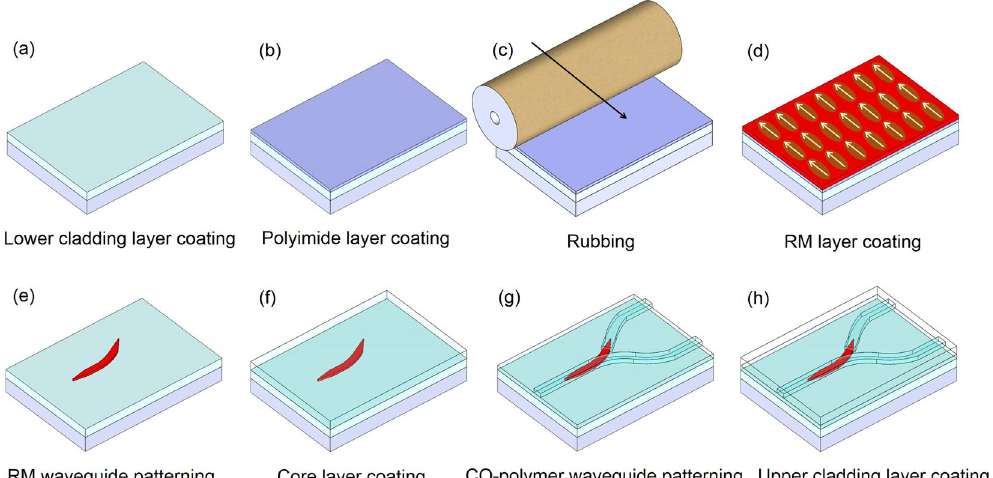
Figure 6. Schematic fabrication procedure of the mode extracting polarization splitter.